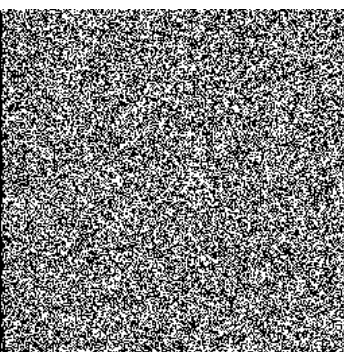
Figure 3. Example bitmap of 256 ∆ encn i values from following 256-bit RSA-OTP random transactions (one value per row). (1) 0xDC5FEA97982EA6FBA2A76B7E76D91A1BF1A83E7262CC81BC739F0957AA61AD38 . (2) 0x7C46EBB147831FB09966AB28C4EF7B5889D6778D738916D2E554045EE59A432C ... (256) 0x177 A17001C0DAC110B7F4EDF42428ABC497E54C5684E0A737C7EC7BE2FD6DC08